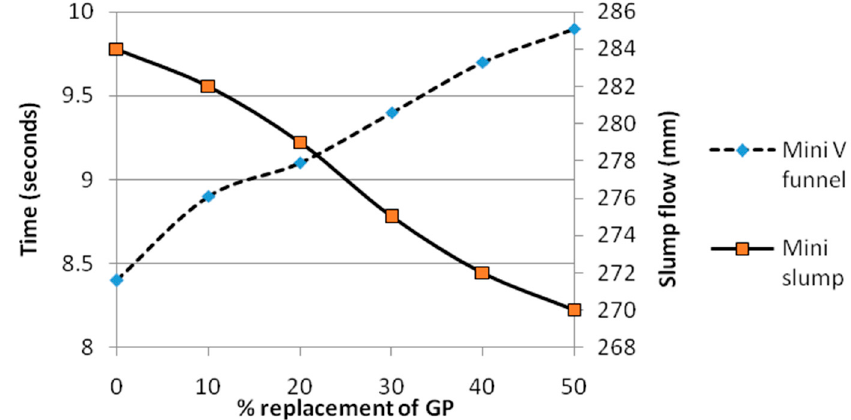
Figure 6. Fresh state results of self-compacting glass mortar.